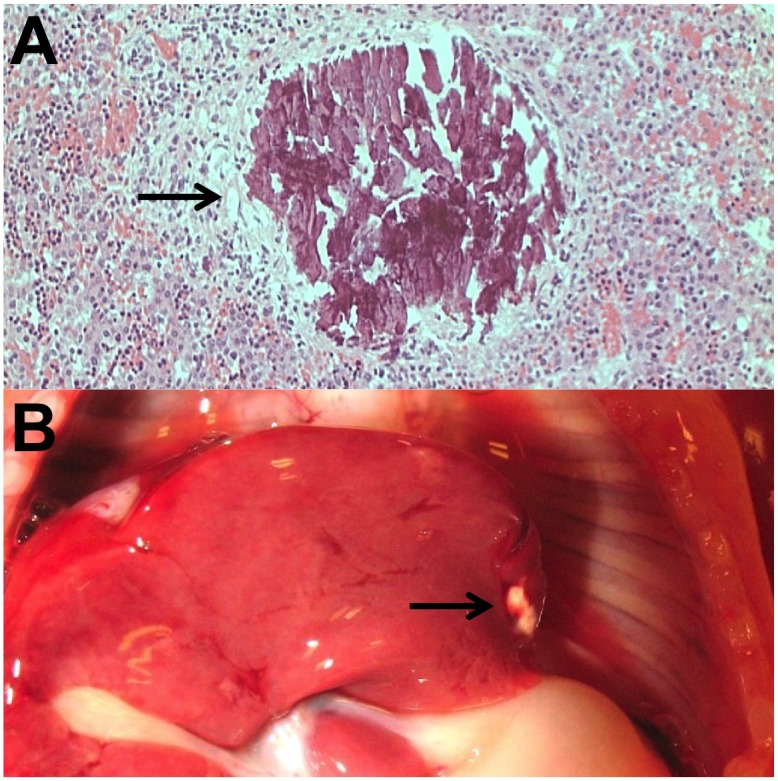
Fetal liver calcification seen on histological section (A) and macroscopically (B).The histological section is stained with Hematoxylin and Eosin, according to standard procedure.